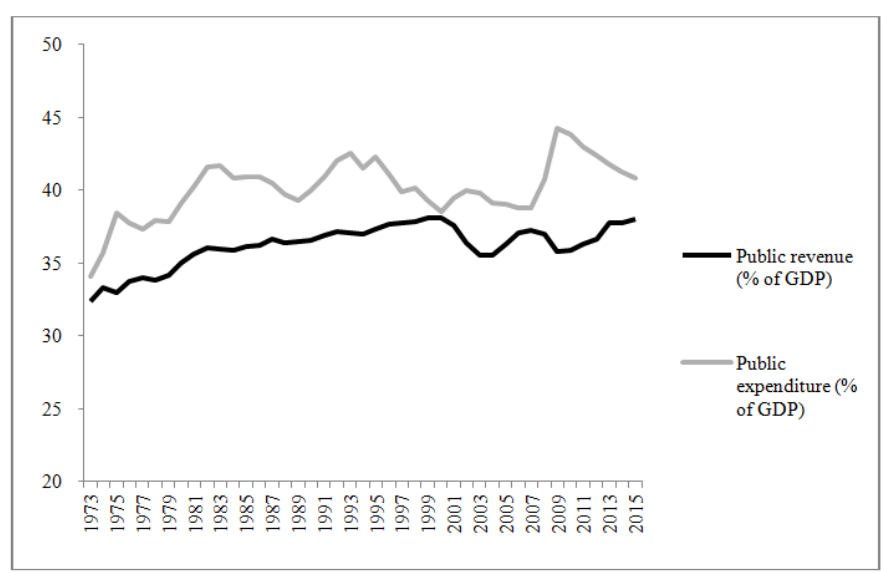
Fig. 1. OECD area public revenue and expenditure (% of GDP), 1973–2016. (OECD, 2017).